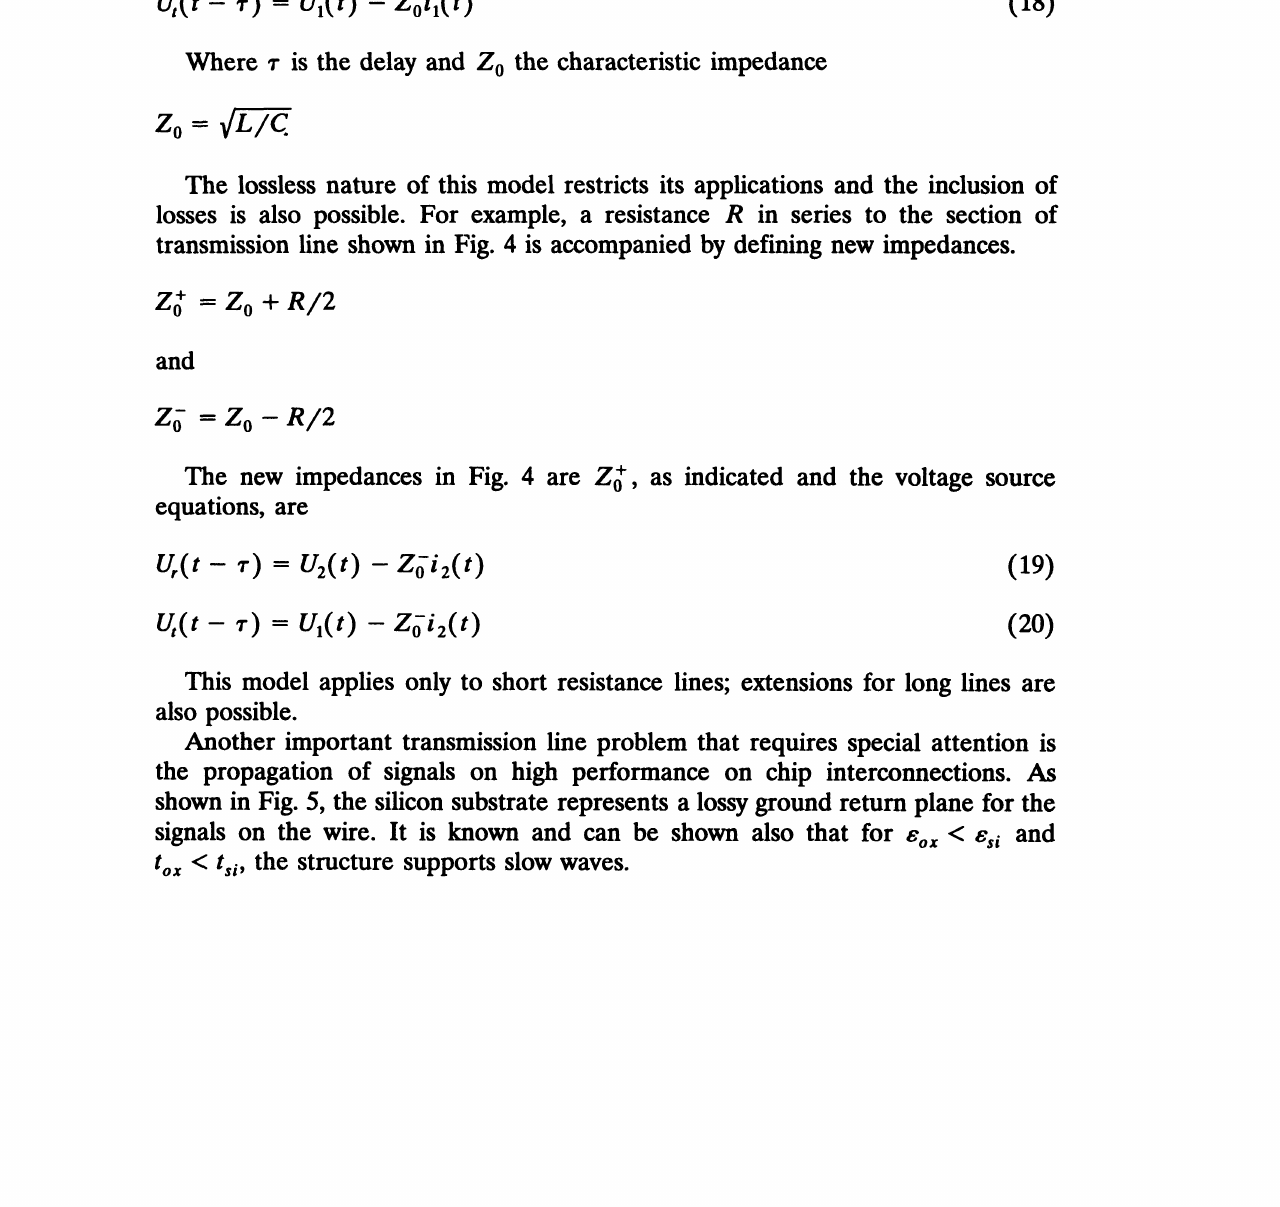
FIGURE 4 Voltage source model for transmission